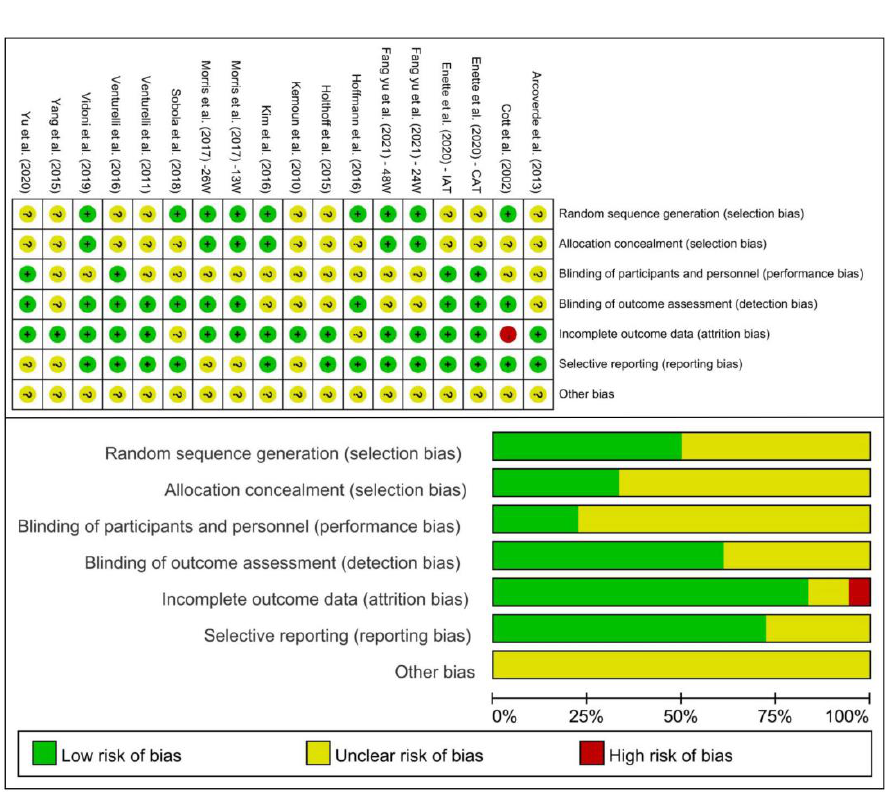
Figure 2. Results of Cochrane risk of bias tool [20,27,28,38 – 49].